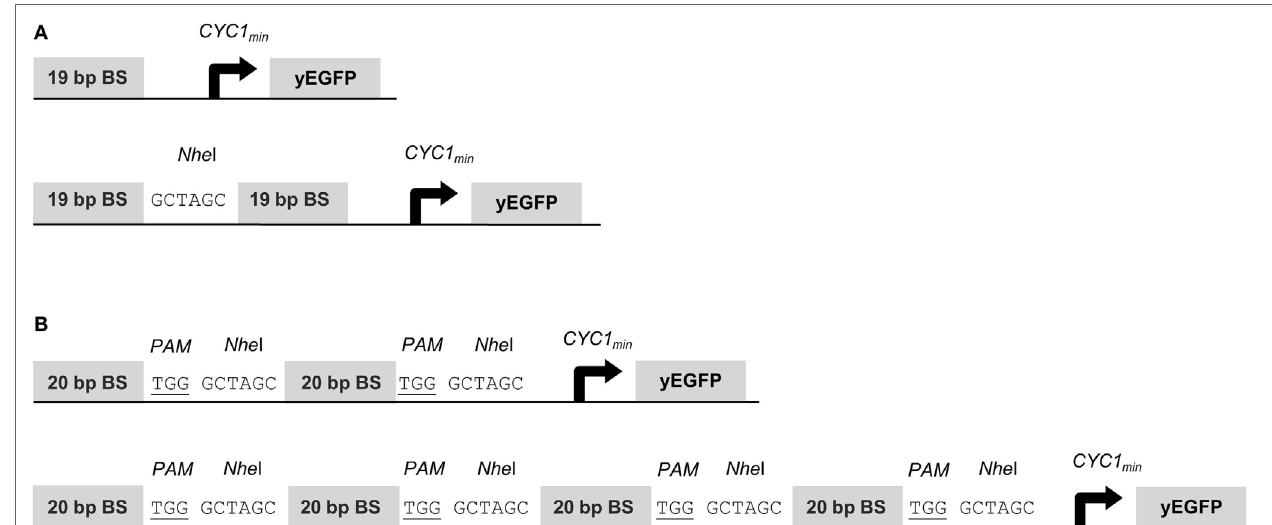
FigUre 1 | Structure of synthetic promoters. The CYC1 minimal promoter ( CYC1 min ) is located downstream of the binding site (BS) array and controls yEGFP expression. (a) BSs for synthetic transcription activator-like effectors (synTALEs) 1–10 are 19 bp long. Up to four direct repeats of the same BS are separated by Nhe I sites. (b) BSs for synTALE11–15 and dead Cas9 (dCas9)-based transcription factors (TFs) are 20 bp long. Direct repeats are flanked by the PAM and a Nhe I